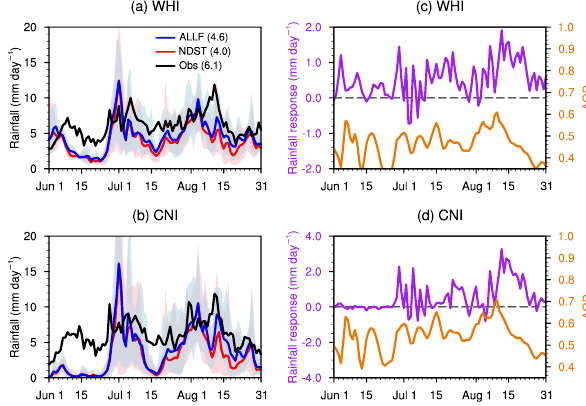
Figure 9. Left: time series of rainfall (mmday − 1 ) in ensemble means of ALLF and NDST experiments and rainfall spread of all 32 ensemble members. Right: ensemble mean rainfall responses (mmday − 1 ) in WHI, and CNI and AOD in DST (from ALLF). Light blue and red colors represent the spread of rainfall in ALLF and NDST members, respectively. The numbers in parentheses are time-averaged rainfall.